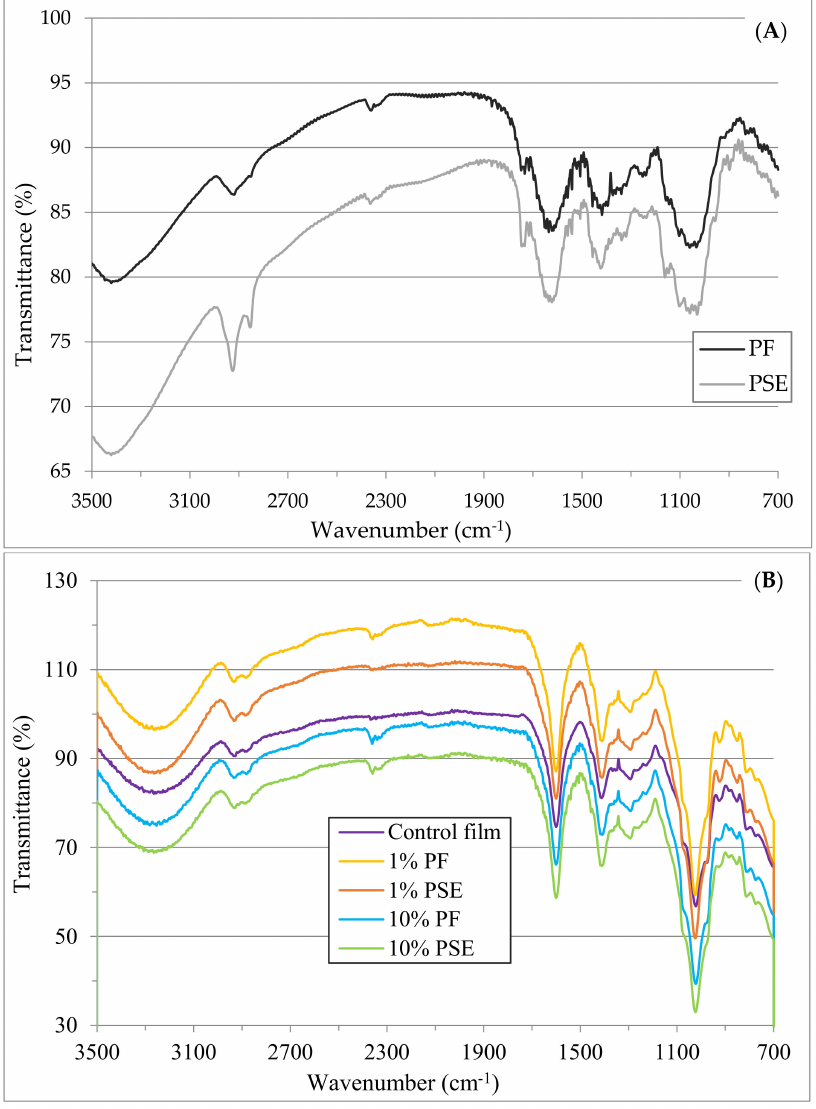
Figure 3. FTIR spectra of ( A ) fibers; ( B ) biobased composite